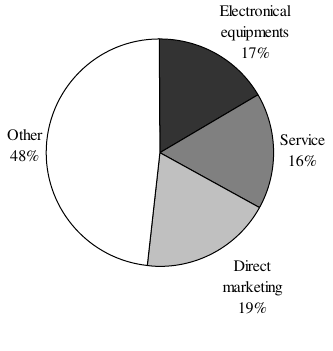
Figure 5. Sectoral distribution of e-stores in